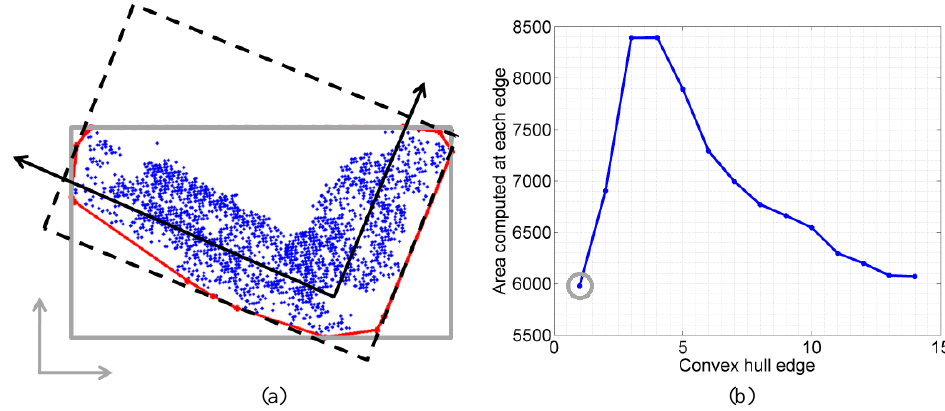
Figure 4: Example depicting failure of MBR to correctly determine the dominant direction of the building footprint: (a) 2-D points of buildings (blue color) are depicted. Convex hull with 14 edges around these points are drawn as red polygon. Grey rectangle is the minimum area bounded rectangle computed via rotating callipers method. It can be seen that the dominant directions estimated via grey MBR do not correctly represent the true dominant orientation of the building points. The desired MBR that correctly represent the dominant orientation is shown as black dotted rectangle; (b) plots the areas of the MBR by rotating MBR around its center of gravity at angles equal to every edge of the convex hull. The grey circle shows the minimum area bounded rectangle corresponding to grey MBR in (a).